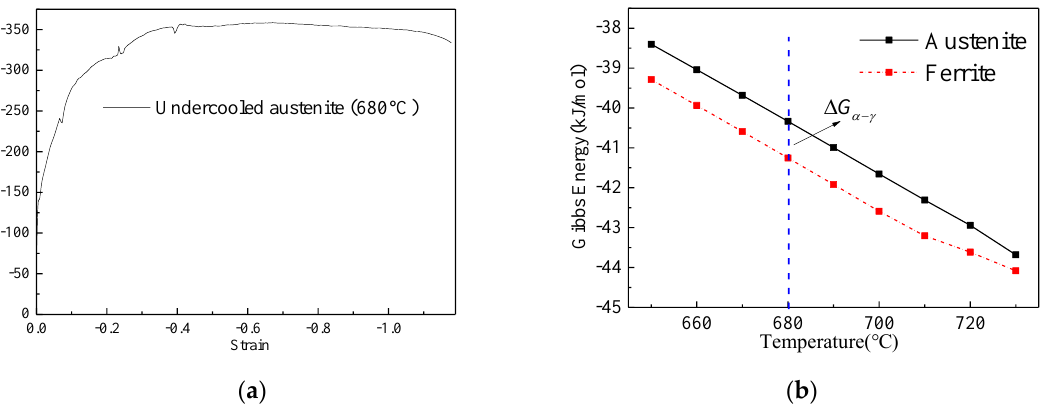
Figure 6. Undercooled austenite follow stress and Gibbs energy of ferrite and austenite; ( a ) austenite follow stress of 680 °C, ( b ) Gibbs energy of ferrite and austenite.